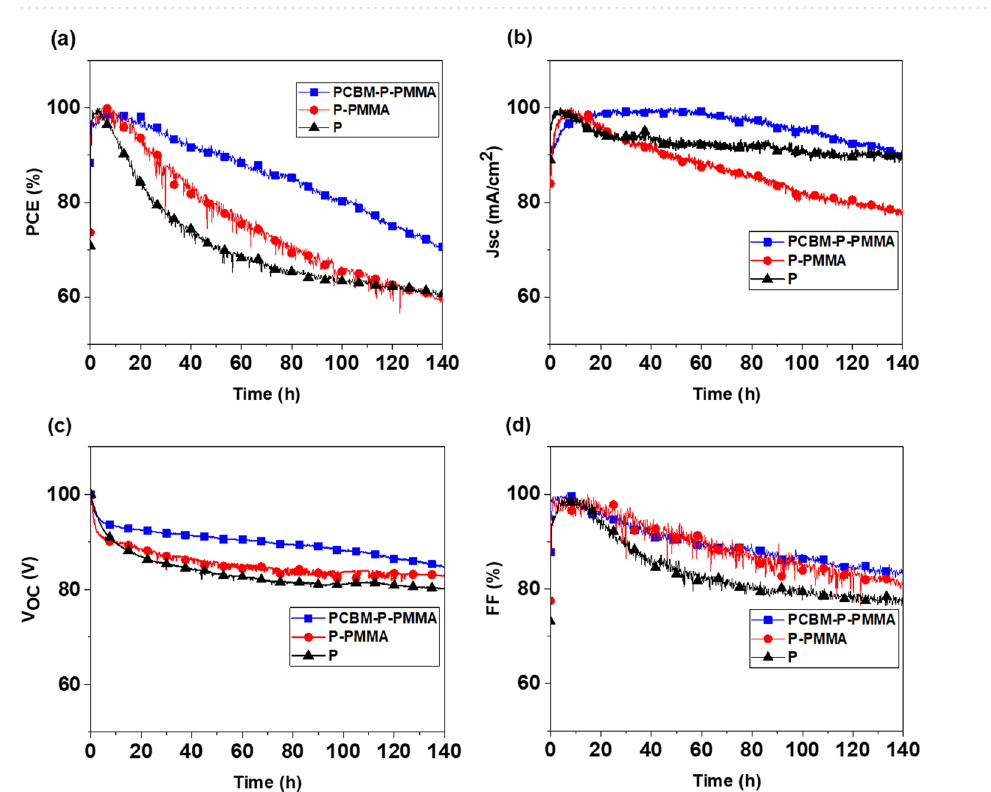
Figure 4. Variation of main normalized photovoltaic parameters ( a ) output power, ( b ) short-circuit photocurrent, ( c ) open circuit voltage, and (d) fill factor of anti-solvent-manufactured devices with two passivation layers (blue curve), one passivation layers (red curve) and without passivation layers (black curve) aged at room temperature after 140 h in a nitrogen